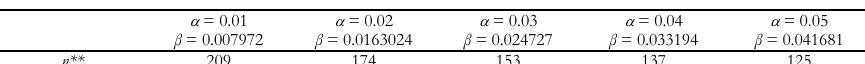
The optimum value of n** for SPRT procedure for testing